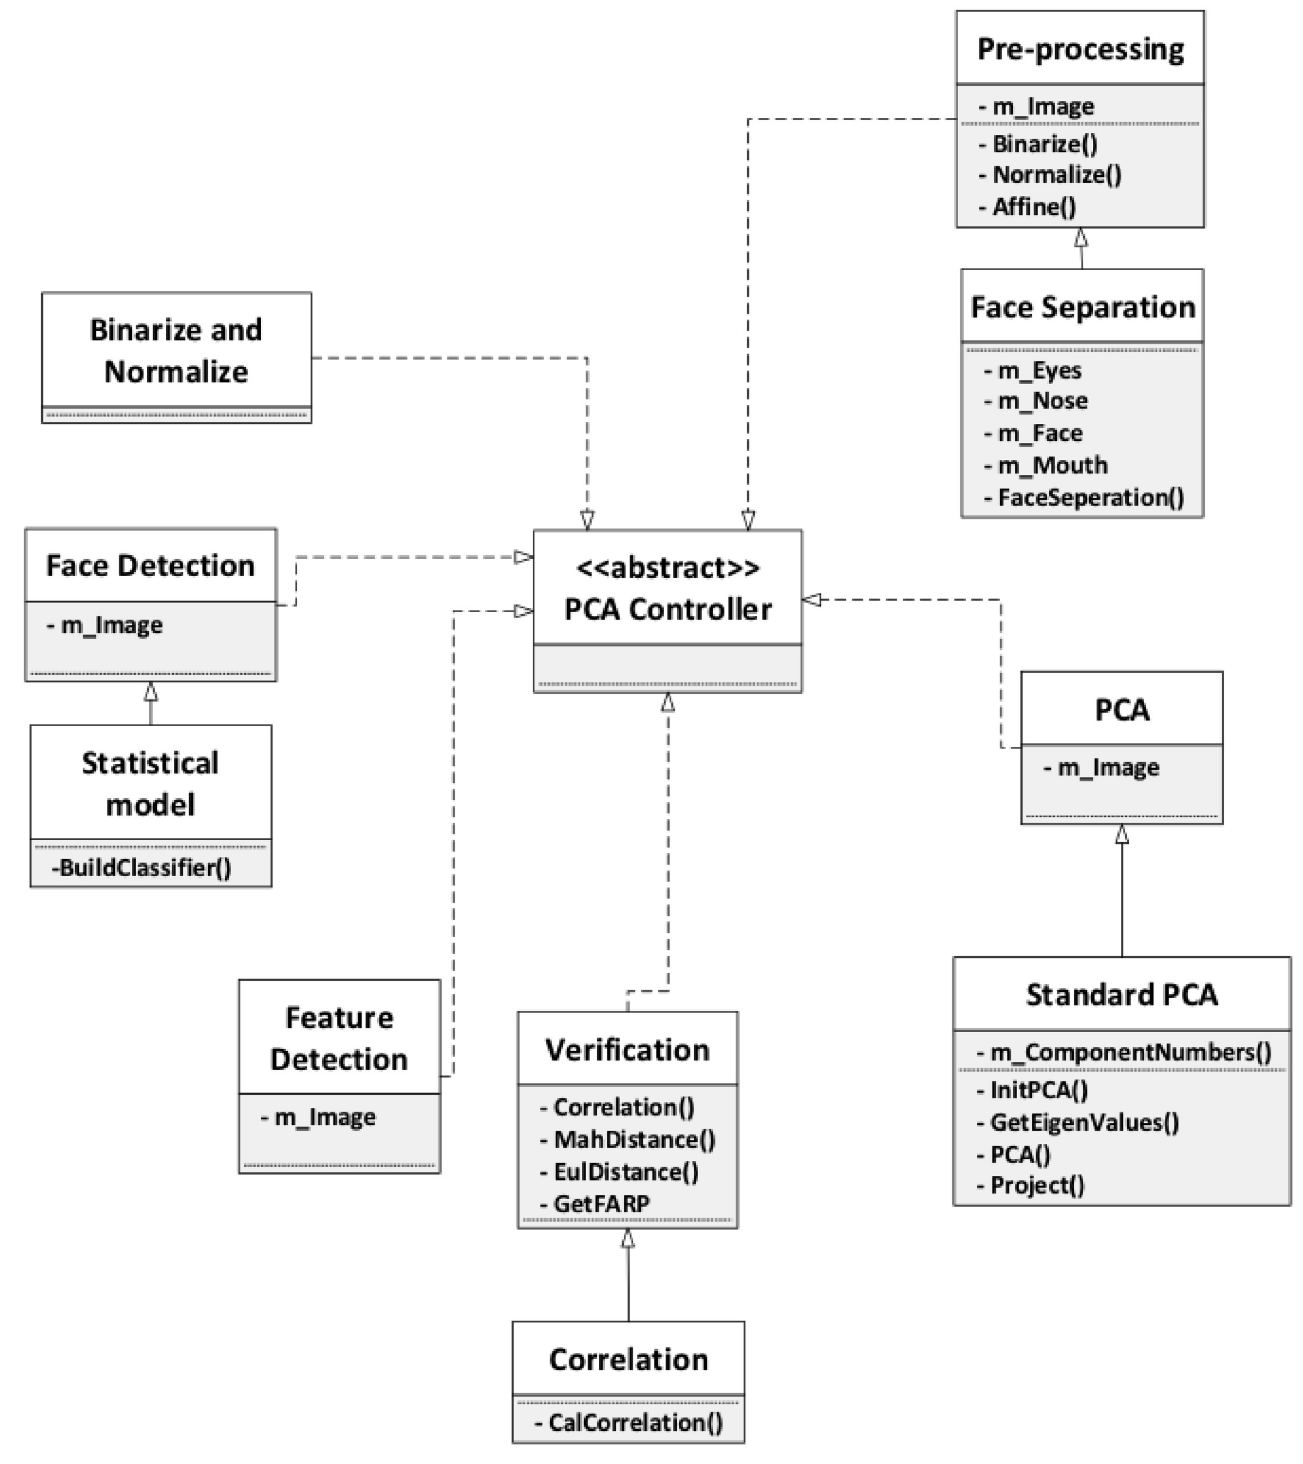
Fig 28. Face recognition for smart phones.